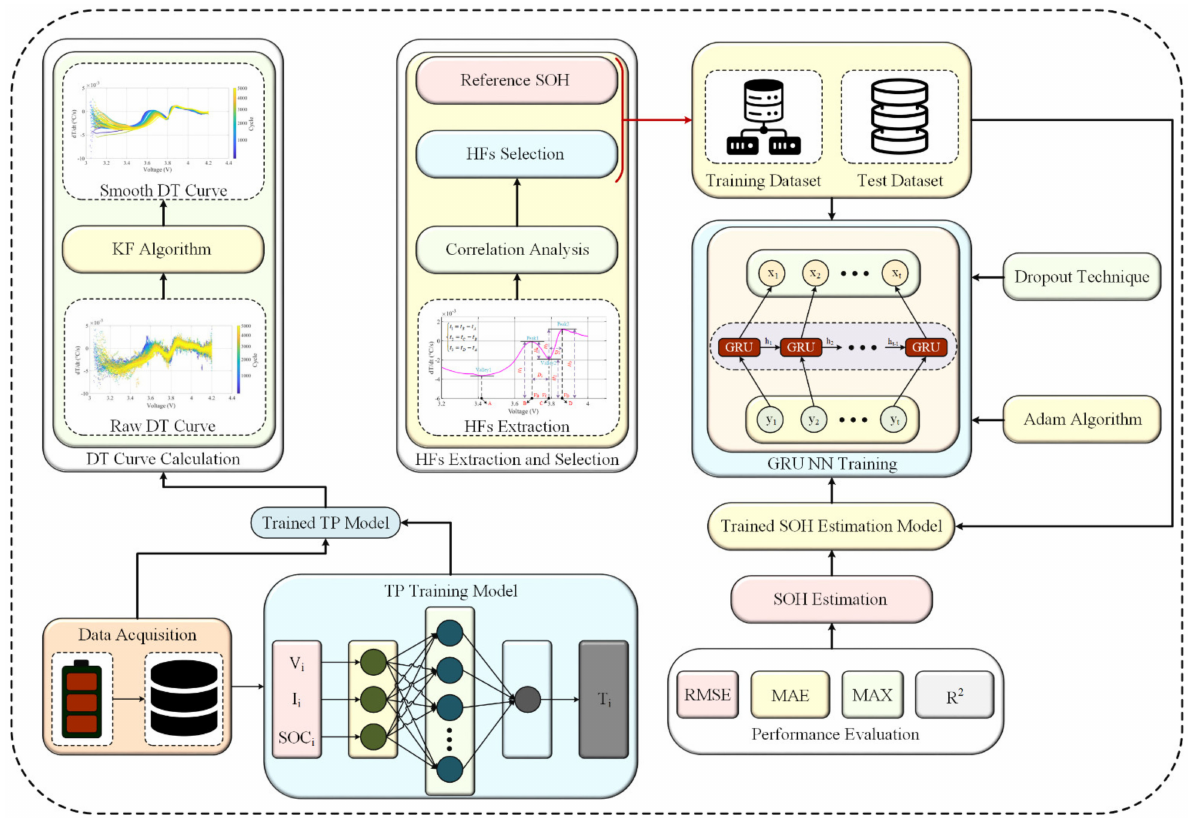
Figure 8. GRU model-based SOH estimation framework for